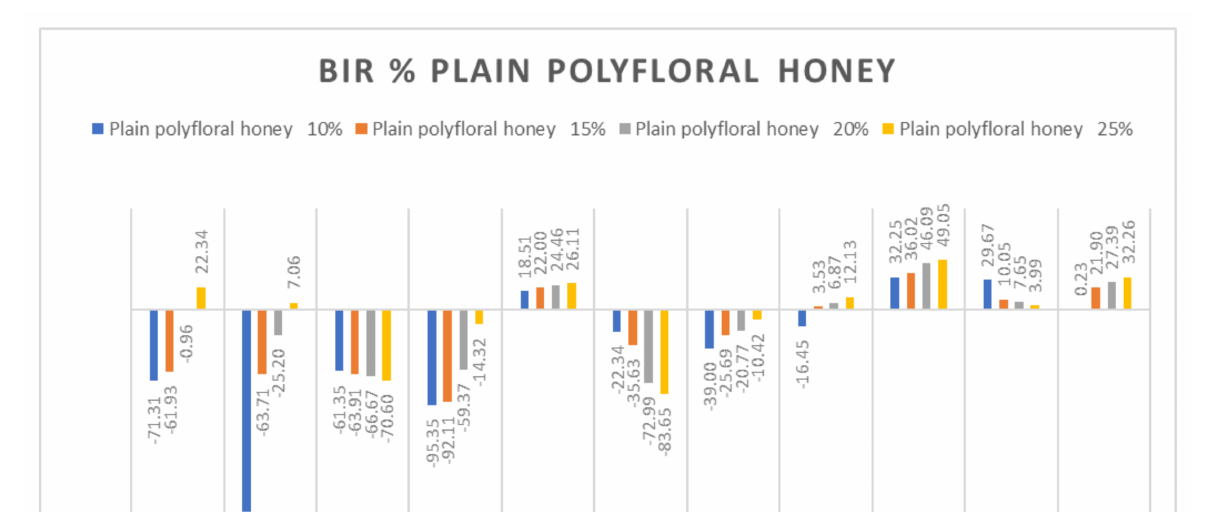
Figure 13. Hill polyfloral honey antimicrobial activity (expressed as BIR%/MIR%) on ATCC strains.